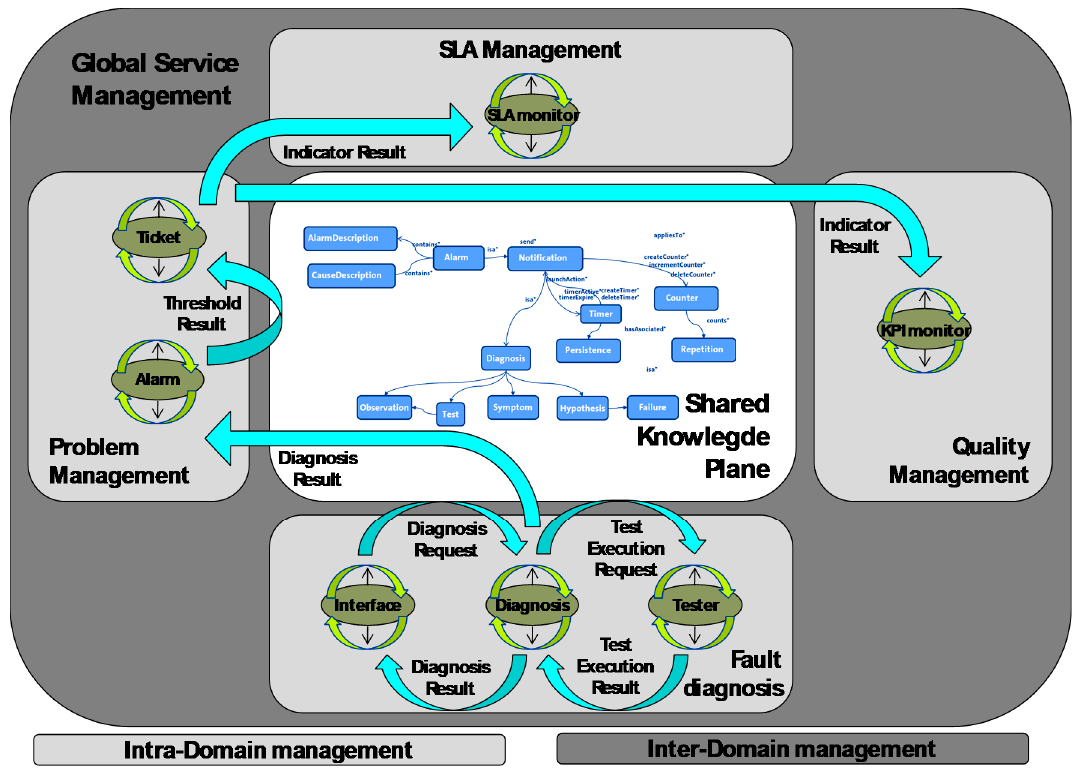
Figure 1. Agent system structure.